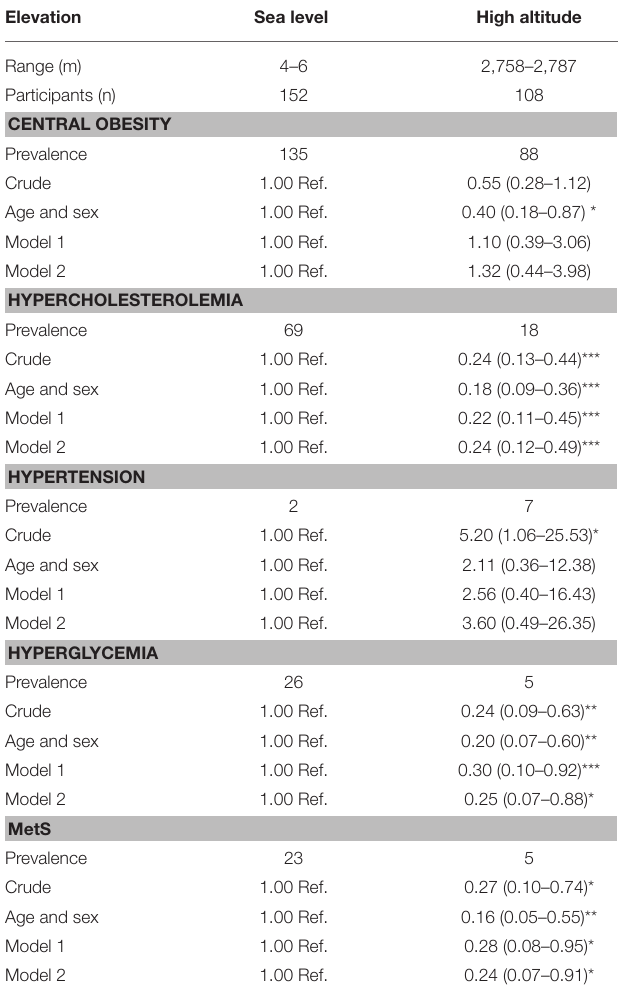
TABLE 2 | Associations between altitude and prevalence of MetS.